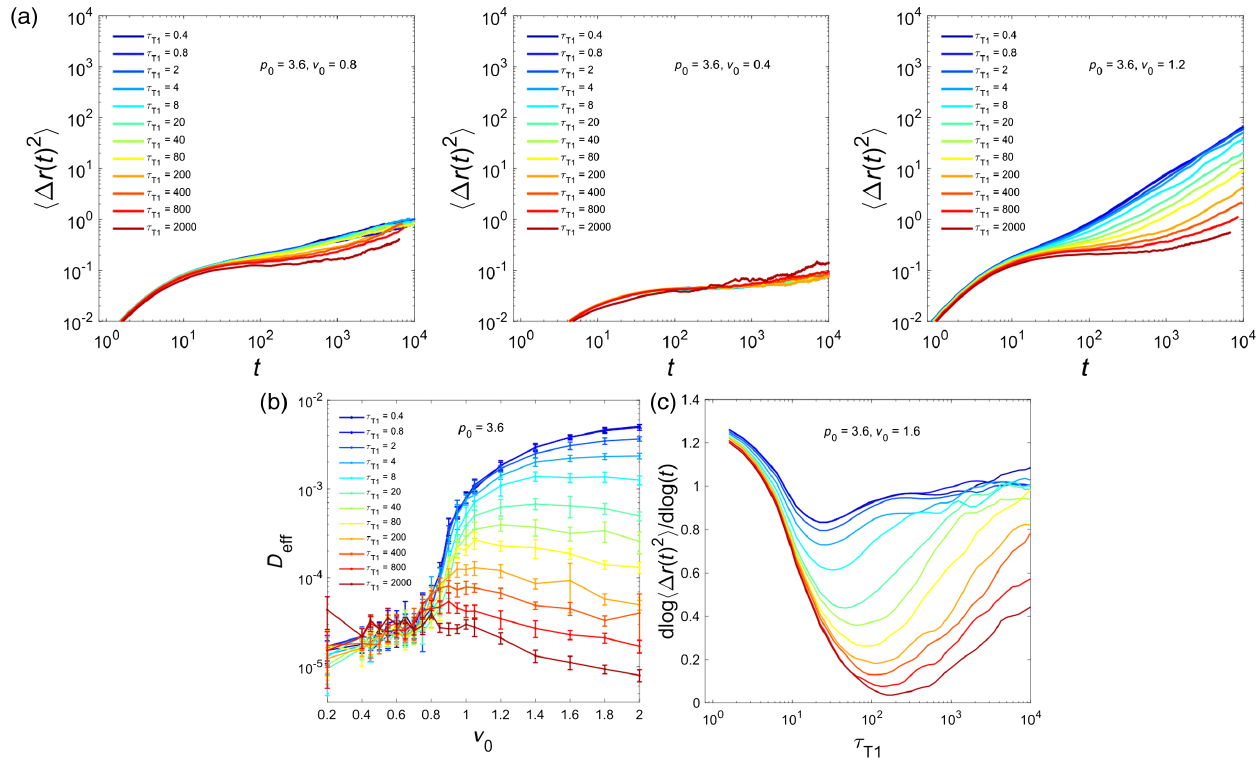
FIG. 8. (a) MSDs for three different v 0 at different τ SEM for n ¼ 10 independent simulations. (c) Time derivative of MSD for v 0 ¼ 1 . 6 . Data shown for p 0 ¼ 3 . 6